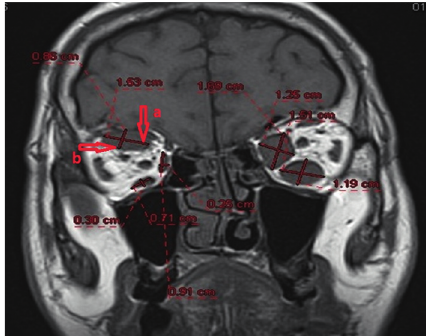
Figure 2: Measurement technique of muscle diameters on MRI. Arrow a shows long diameter and arrow b shows short